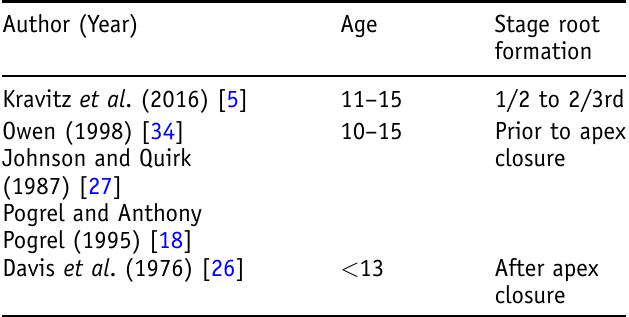
Table I. Shows age and root formation stage for surgical up- righting recommended by various